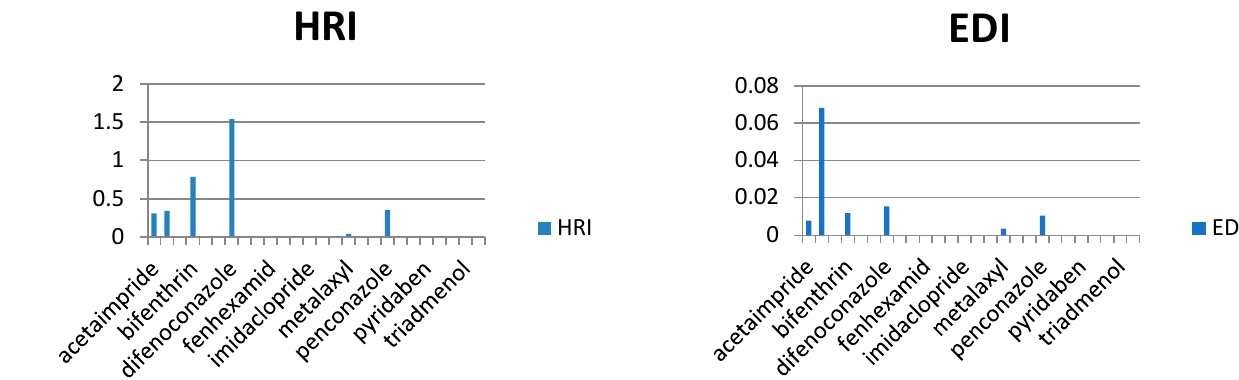
Figure 5. Estimation of EDI and HRI for pesticide residues detected in sweet peppers.